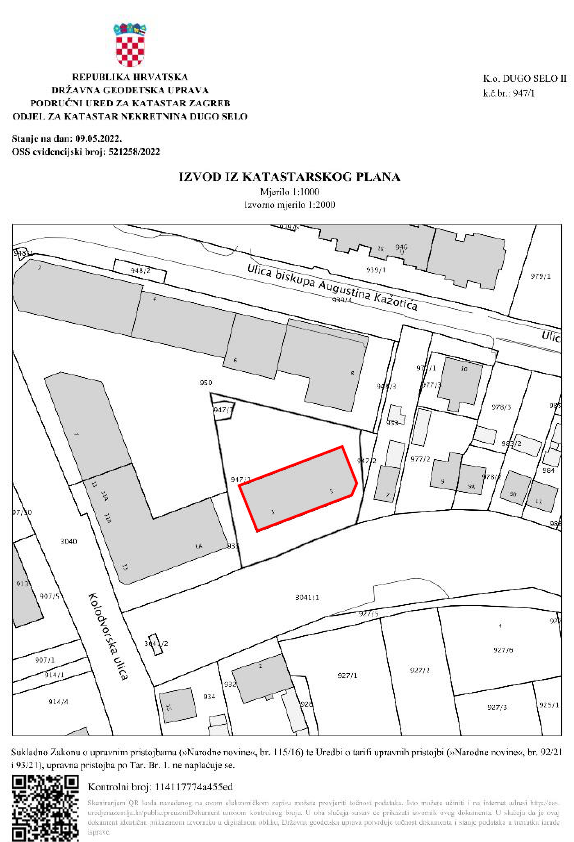
Figure 3 . Excerpt from a Land Database – cadastral map